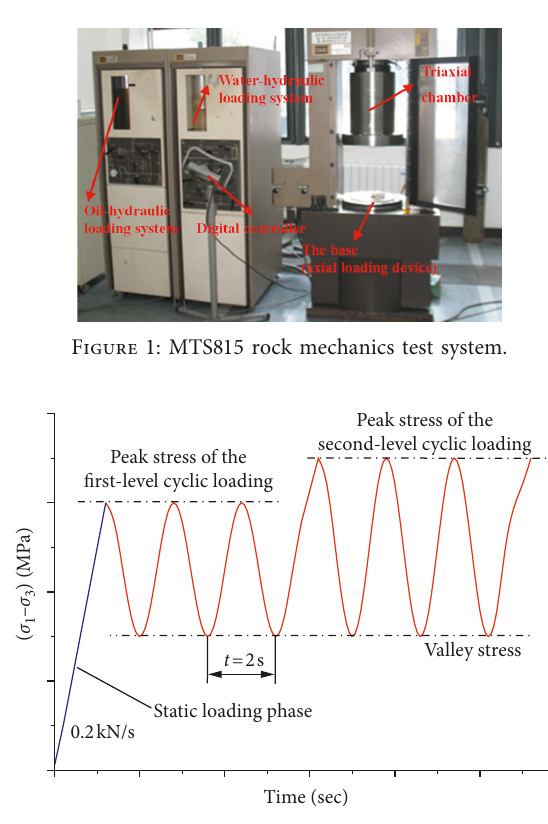
Figure 2: Diagram of the two loading phases in the cyclic loading